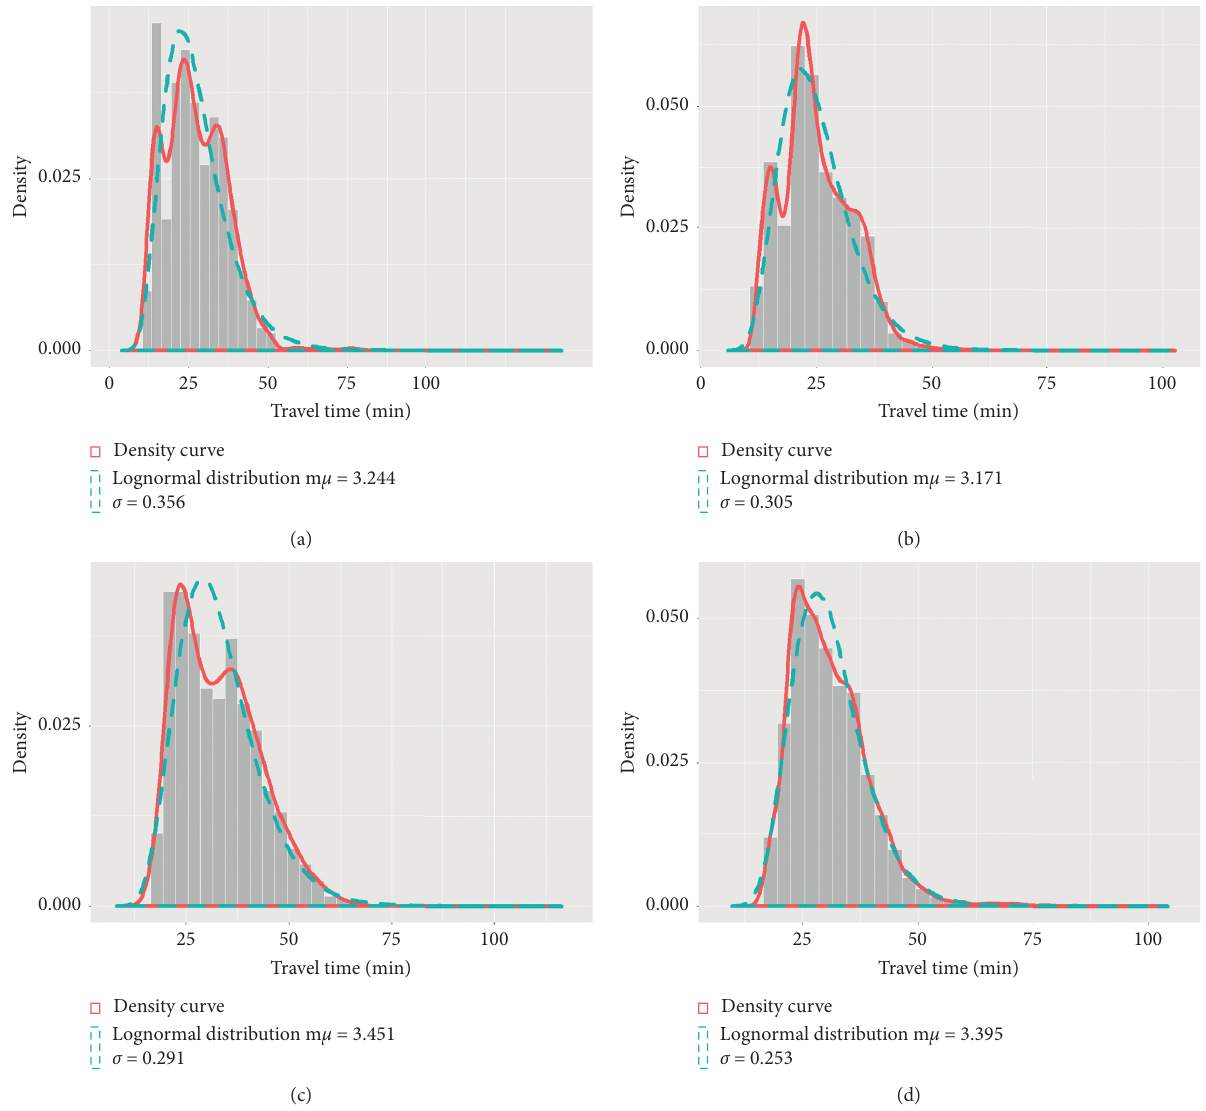
Figure 4: Selected distributions for the observed travel time data under different weather conditions. (a) Adverse weather of elevated expressway, (b) normal weather of elevated expressway, (c) adverse weather of urban arterial road, and (d) normal weather of urban arterial